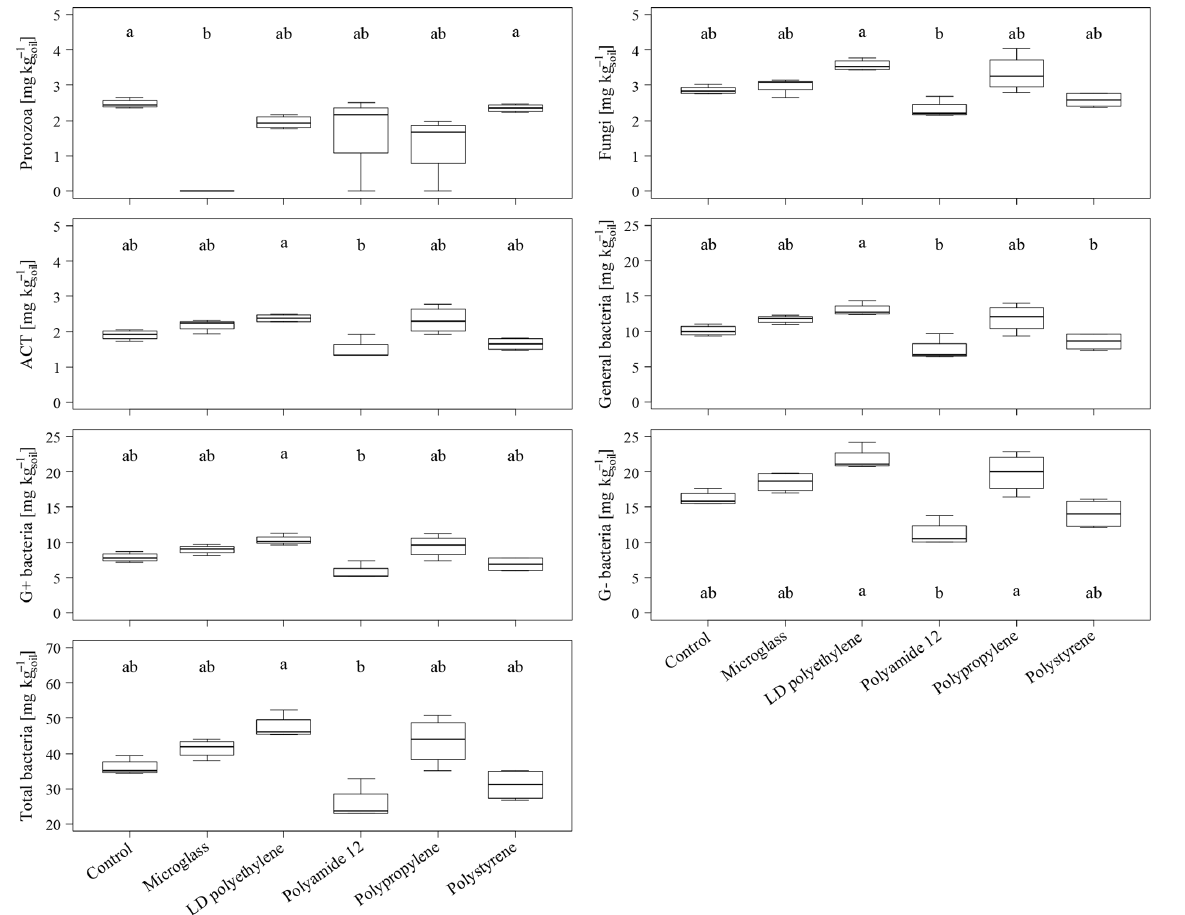
Figure 3. Microbial-derived phospholipid fatty acid contents of the individual taxonomic groups of an incubated Chernozem after 80d. Different lowercase letters indicate significant differences in the treatments according to a multiple comparison with the Dunn’s test ( n = 4, p< 0 . 05). Please note the varying ordinate